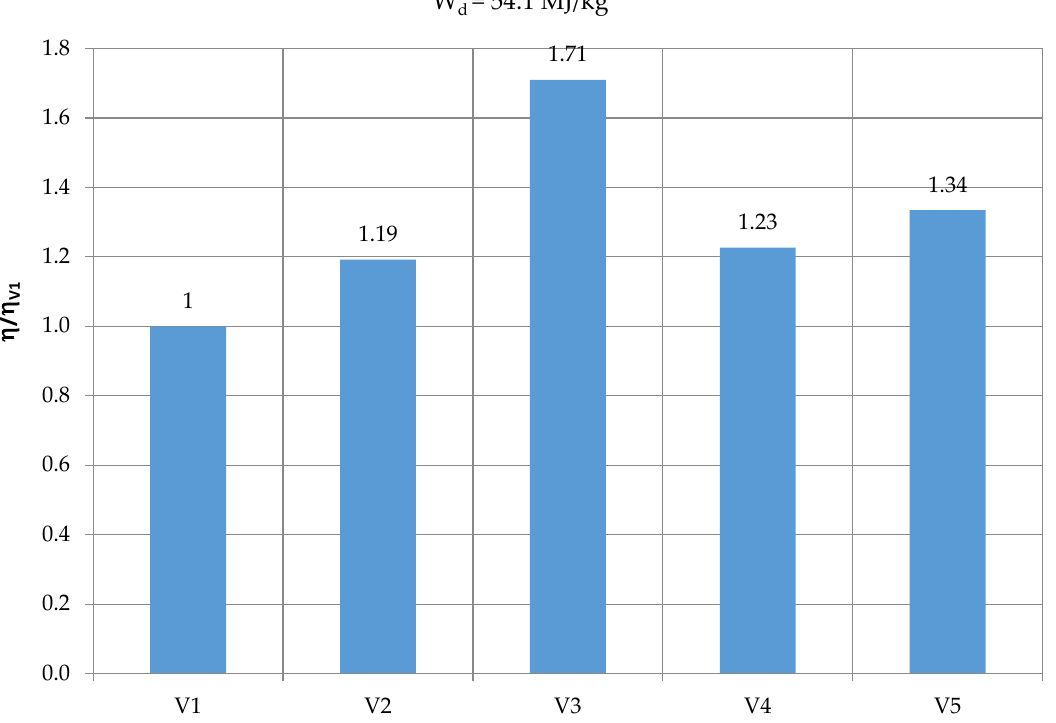
Figure 9. The influence of the cycle structure on its efficiency as compared to variant 1 for methane.